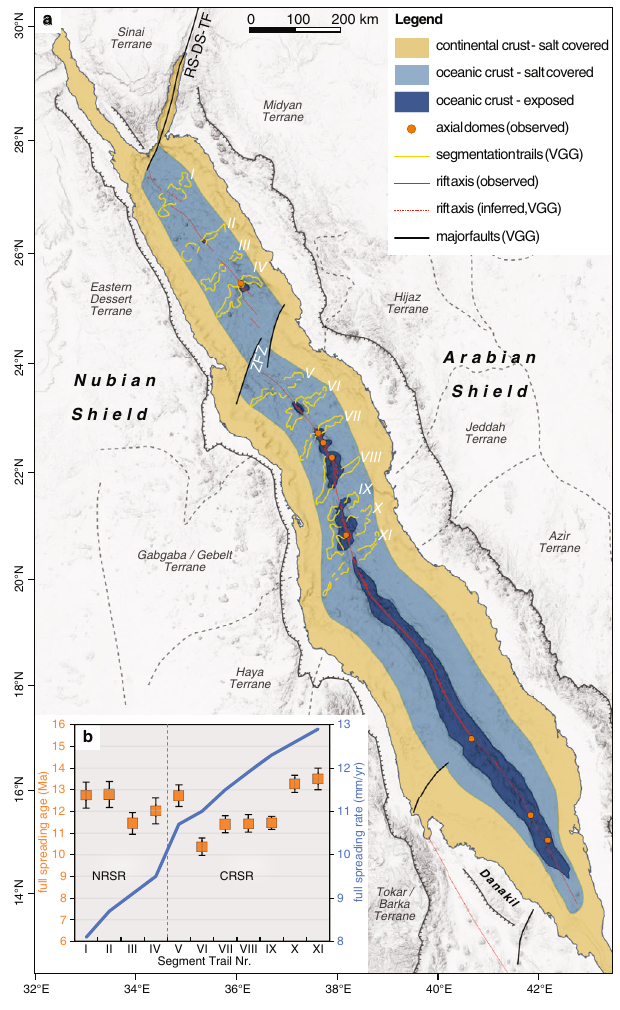
Fig. 6 Resulting tectonic model for the Red Sea Rift. a The tectonic model of the Red Sea Rift is the result of combined observations from vertical gravity gradient (VGG) data, seismic activity and latest bathymetric maps and favours a continuous ocean crust along the entire length of the basin that is buried in large parts under salt and sediment fl ows (see legend, oceanic crust — salt covered). The only right-lateral, fi rst-order offset of the rift axis is located in a signi fi cant fault zone at about 24°N (ZFZ = Zabargad fracture zone). The rift axis is further systematically offset by second-order non-transform offsets at segment ends, but no other fi rst-order offsets (i.e. transform faults) can be observed along the rift axis. Off-axis segmentation trails identi fi ed from VGG represent mid-ocean ridge axial segmentation and mark the minimum extend of the oceanic crust. They are numbered from north to south (for details see text). b Plotted spreading ages of the rift-perpendicular segmentation trails show ages of up to 12.8 Myr in the northern Red Sea Rift (NRSR) and 13.5 Myr in the central Red Sea Rift (CRSR), averaging at 12.1 Myr (orange squares; error bars represent minimum and maximum range of calculated ages, see also Table 1). The full spreading rates are plotted by the blue line as listed in Table 1 and discussed in the text. RS-DS-TF = Red Sea – Dead Sea transform fault.